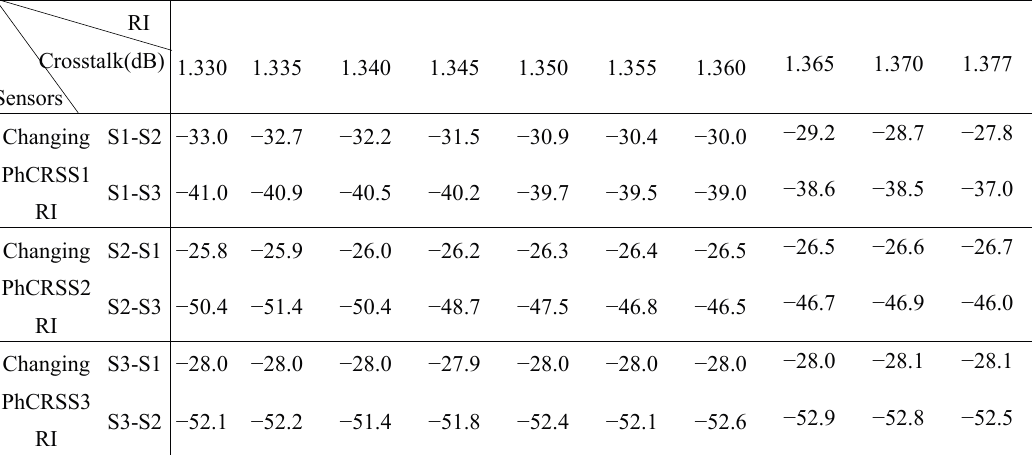
Table 1. The maximum crosstalk (dB) between the proposed ring-slot sensors array (PhCRSS1, PhCRSS2,